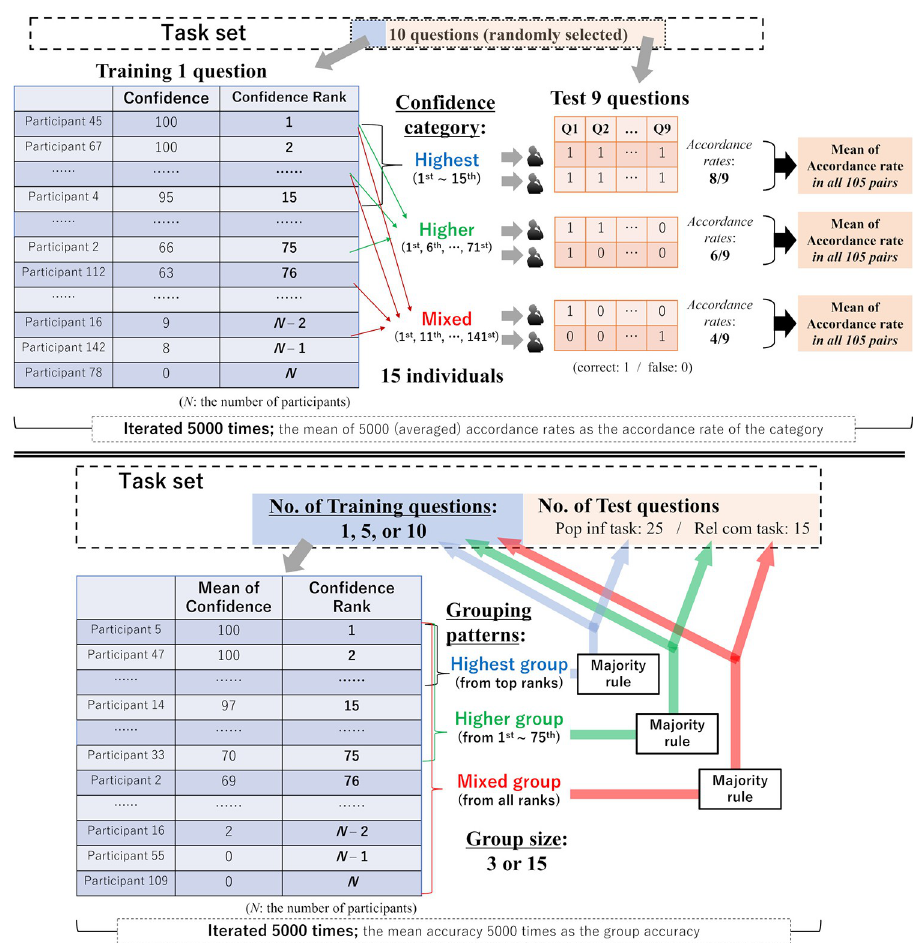
Fig 4. Schematics of the two computer simulations. We split the binary choice questions used in behavioral experiments into two sets (“training questions” and “test questions”) and iterated the procedures 5,000 times in both simulations. Upper: accordance rates between two individuals’ judgments. We collected 15 individuals in 3 patterns (highest, higher, or mixed) based on the confidence rating rankings in 1 training question. For each category, we examined the extent to which one participant’s responses accorded with another participant’s responses in nine test questions. Lower: group judgments for the training and test questions. We generated hypothetical groups based on individuals’ confidence ratings in the training questions. Then, in both the training and test questions, we calculated the accuracy of group judgments by a majority rule. The underlined descriptions denote the conditions we manipulated (“No. of Training questions”: 1, 5, or 10. “Group size”: 3 or 15. “Grouping patterns”: highest group, higher group, or mixed group). For details on the procedure, see the main